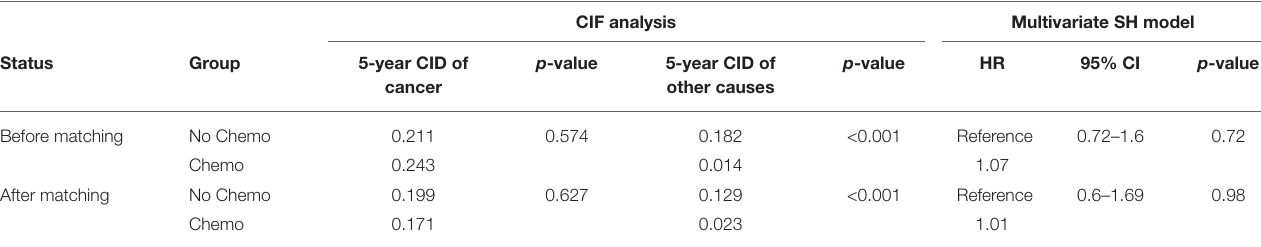
TABLE 2 | The role of chemotherapy for metaplastic breast cancer (MBC) by CIF analysis and multivariate SH model before and after